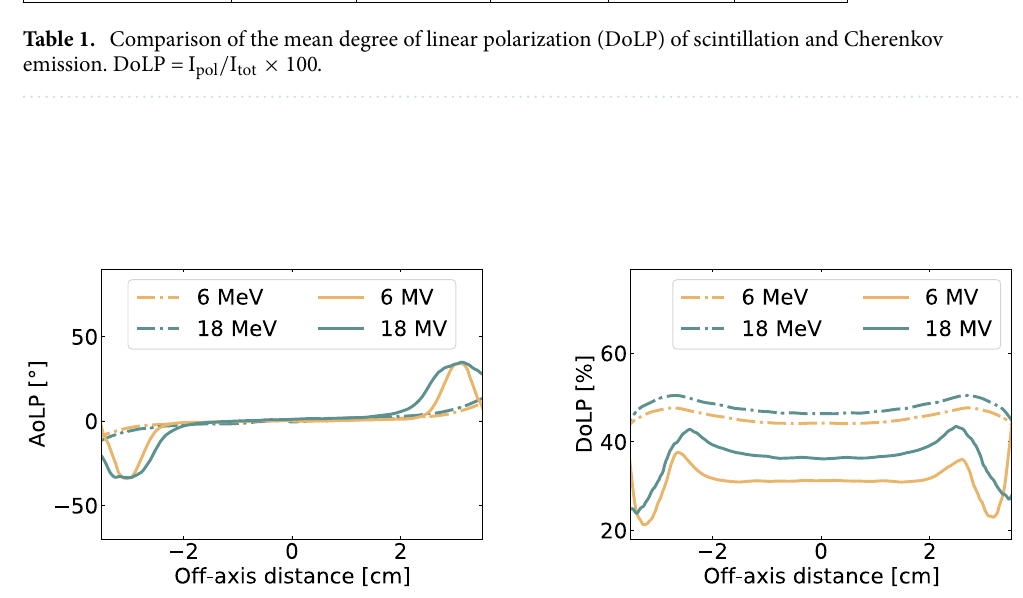
Figure 5. Angle (left) and degree (right) of linear polarization along profiles for the 6 MeV, 18 MeV, 6 MV and 18 MV beams. The profiles are taken at the depth of maximum dose for each